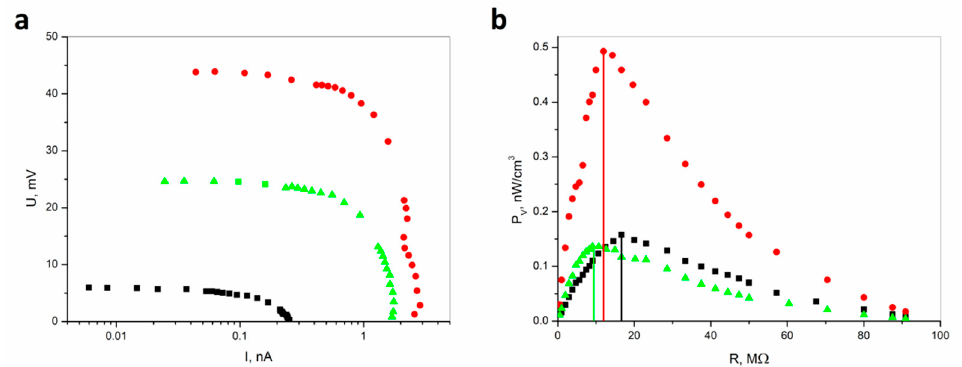
Figure 2. ( a ) Comparison of U–I characteristics and ( b ) volume power density (P V ) recorded under vibration excitation (f = 24 Hz, A = 1 mm) for di ff erent load resistances for CSNC ( (cid:4) ) and for ESNC with 20% ( ● ) and 40% ( ▲ ) concentration of SbSI nanowires. The vertical lines indicate the values of sample resistance corresponding to the power maximum (description in the text).